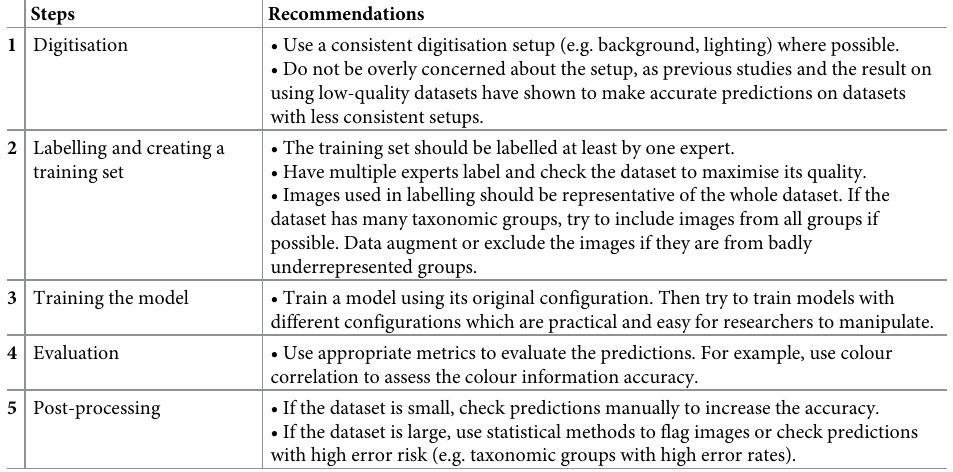
Table 2. Recommendations on each step of building Deep Learning pipelines to label points on large-scale biodi- versity